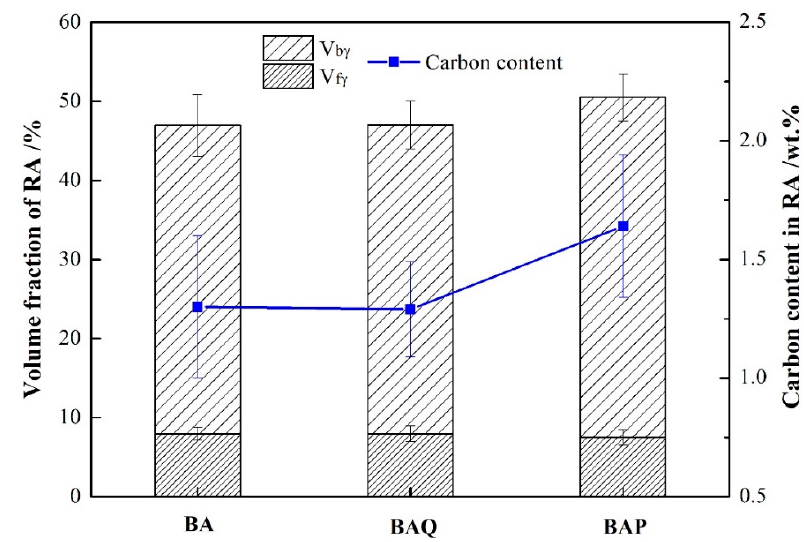
Figure 3. The volume fraction and carbon content of retained austenite. Table 2. Measured data for the BA, BAQ, and BAP samples.